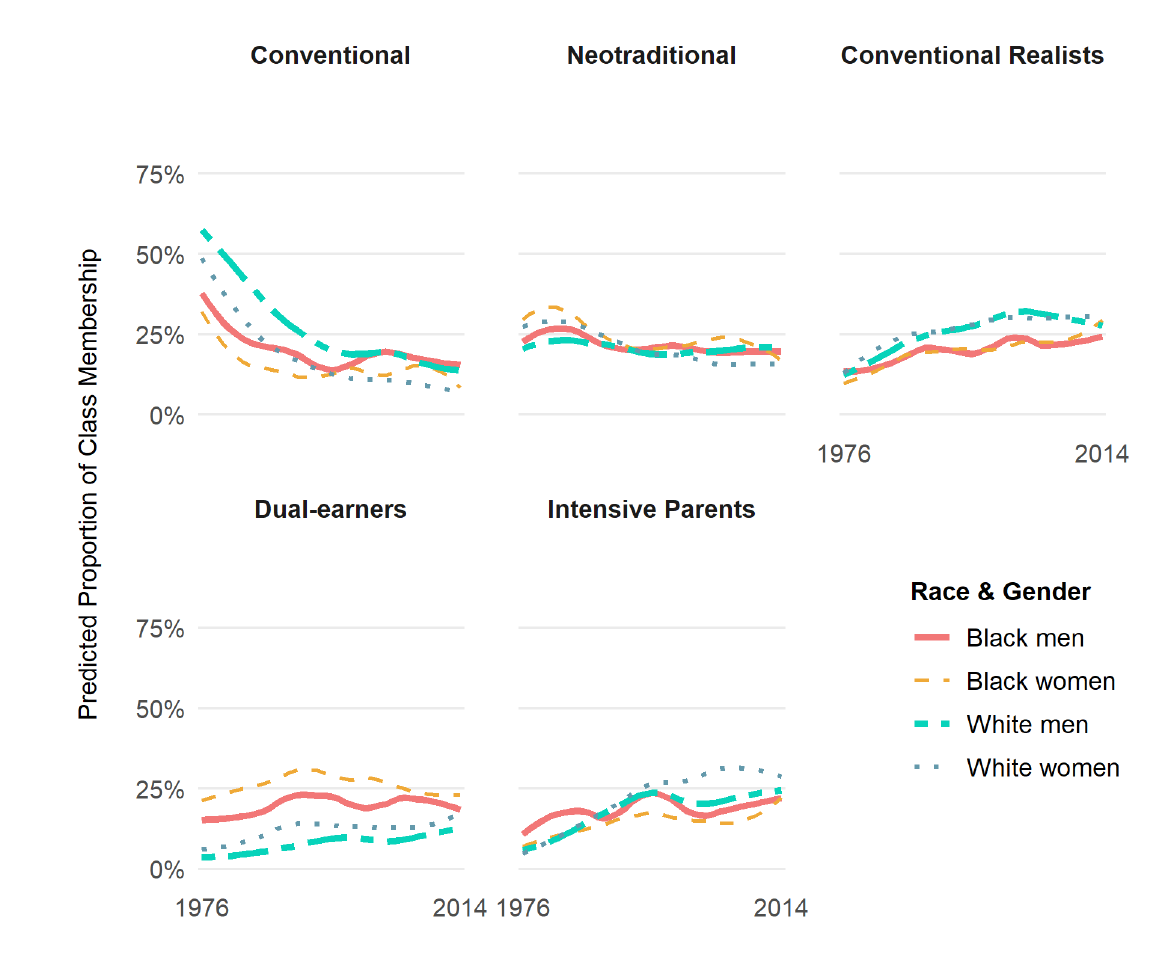
Figure 3: Predicted proportion of latent class membership from 1976 to 2014 by race and